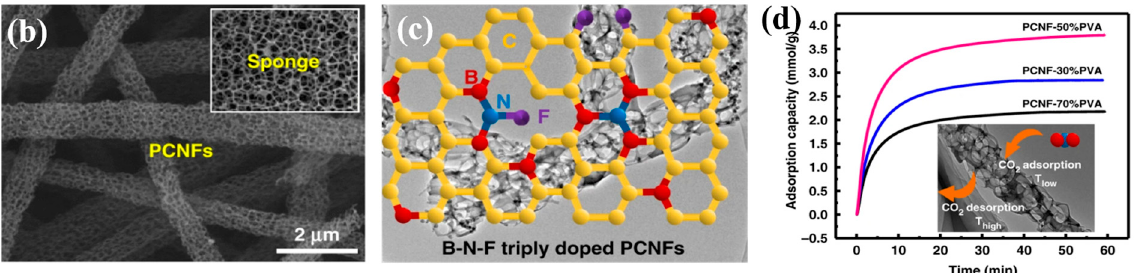
Figure 5. ( a ) Schematic diagram of PCNF synthesis via electrospinning and post-heat treatment; ( b ) SEM image of PCNFs; ( c ) chemical model of B-N-F triple-doped PCNFs; ( d ) CO 2 adsorption performance of PCNFs. Reprinted with permission from Ref. [134], Copyright 2019, Springer Nature.